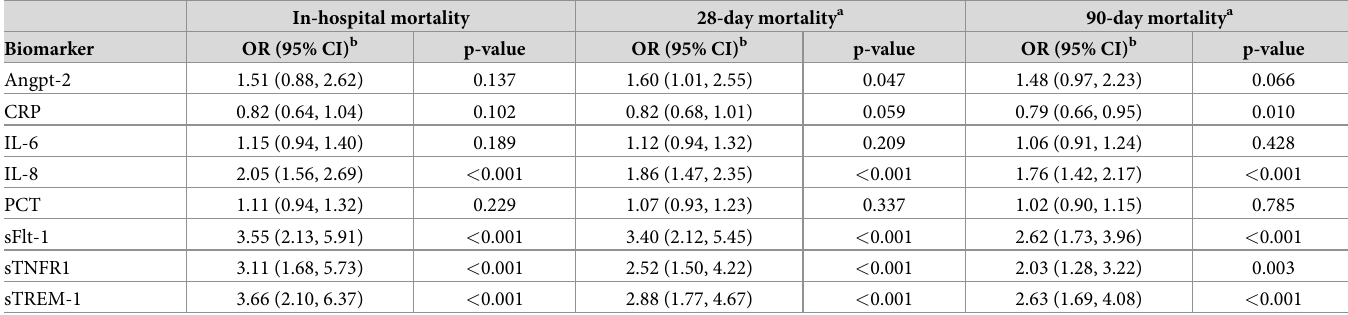
Table 2. Associations of biomarkers with primary and secondary outcomes using univariable logistic regression. In-hospital mortality